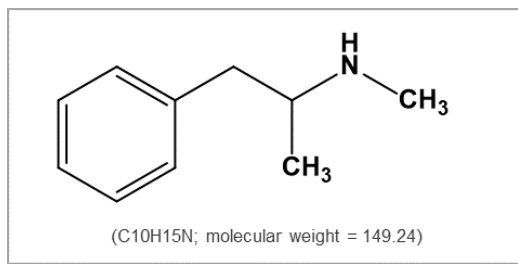
Figure 1. Chemical structure of methamphetamine.